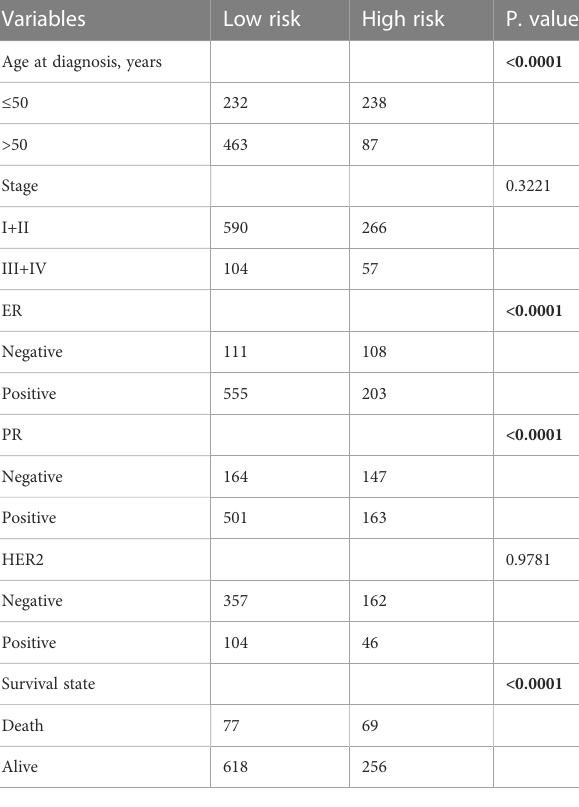
TABLE 1 Clinicopathological associations of CRSS in breast